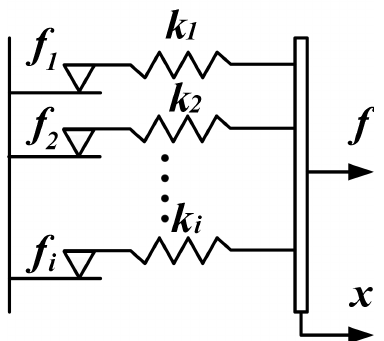
Figure A1. Modified Iwan spring-slider